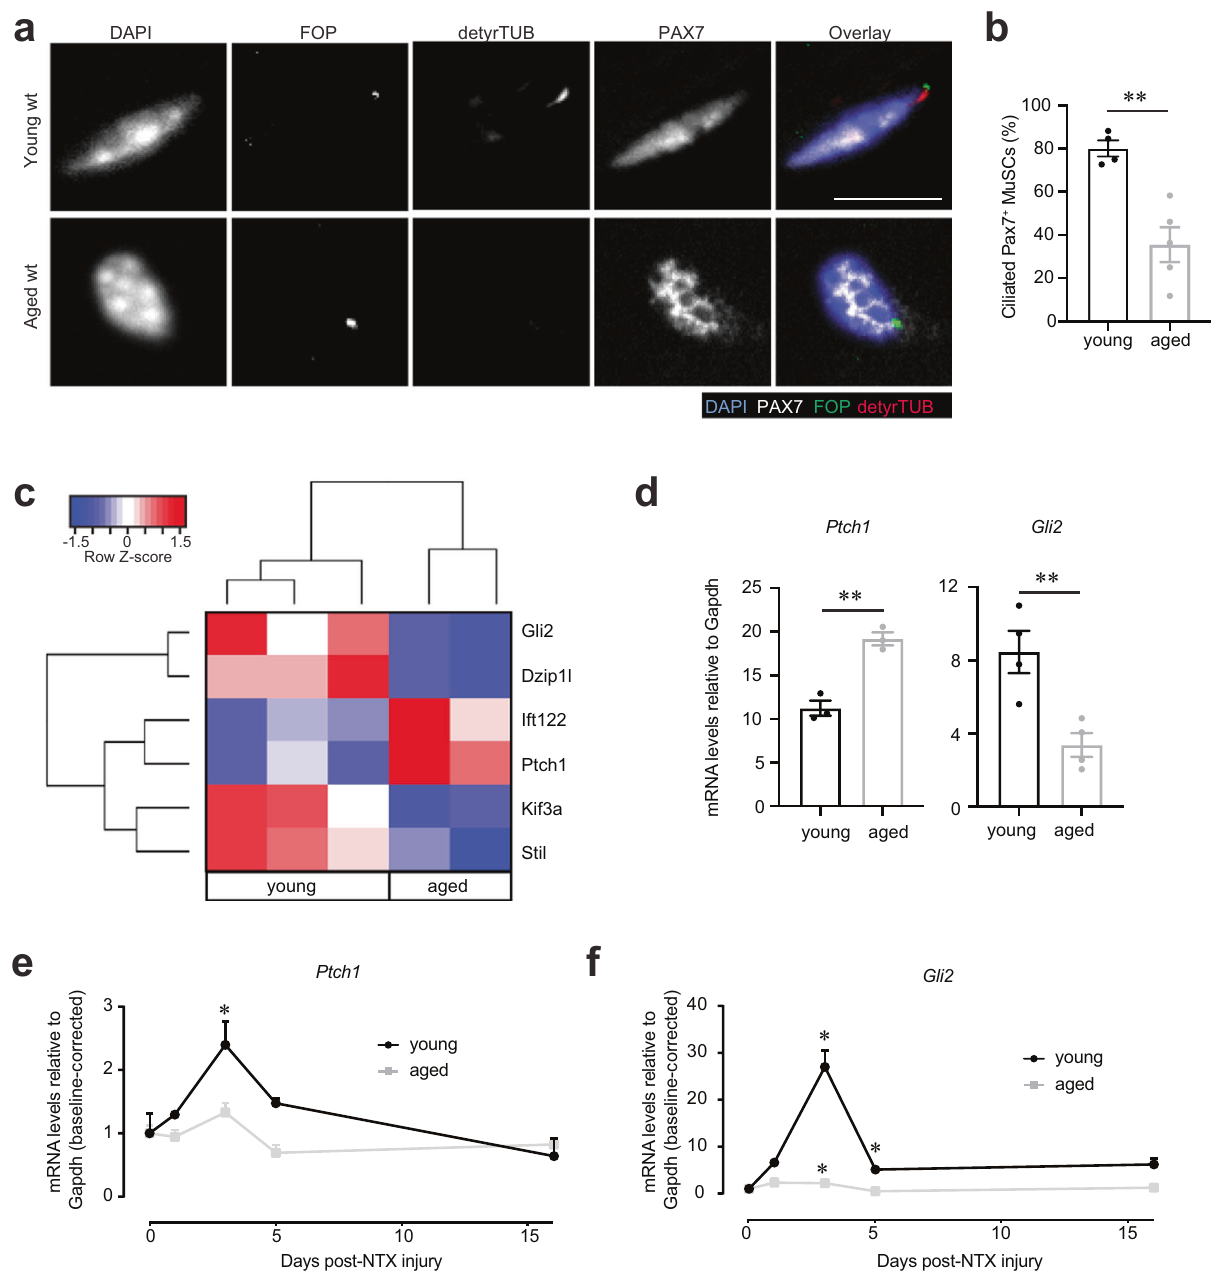
Fig. 4 Aged MuSCs present decreased ciliation and Hedgehog signaling. a Representative confocal images of uninjured/resting EDL myo fi bers of young (2 months) and aged (>24 months) C57BL/6 wild-type (wt) mice showing cilia immunostaining in Pax7 + MuSCs. Scale bars: 10 μ m. DAPI, blue; PAX7, white; FOP, green; detyrosinated tubulin, red. b Percent of ciliated Pax7 + MuSCs quanti fi ed from isolated myo fi bers ( n = 58 myo fi bers total per age group isolated from n = 4 young and n = 5 aged mice, average percent of ciliated MuSCs per mouse is shown). c Heat map of differentially expressed Hh pathway genes in young and aged MuSCs. d Expression of the negative regulator of Hh signaling, Ptch1 , is increased in aged MuSCs, while the target gene Gli2 is decreased in aged MuSCs compared to young as determined by qPCR analysis ( n = 4 mice per age group). e , f Expression of Ptch1 ( e ) and Gli2 transcription factor ( f ) after Tibialis anterior (TA) muscle injury (notexin) ( n = 3 – 7 mice per timepoint and age group, individual data points in Supplementary Fig. 4c, d). * P < 0.05, ** P < 0.01, *** P < 0.001 **** P < 0.0001. Mann – Whitney test ( b , d ). ANOVA test for group comparisons and signi fi cant difference for each timepoint relative to Day 0 by Fisher ’ s LSD test ( e, f ). Source data are provided as a Source Data fi le. Means + the Sonic-Hedgehog (Shh) ligand which activates signaling by ~30% of ciliated aged MuSCs suf fi ces to improve muscle regen- binding PTCH1 and derepressing SMO 39 . We found that each of eration in the aged, we treated isolated MuSCs from aged mice with SAG1.3. This resulted in a signi fi cant increase in proliferation the SMO agonists we tested signi fi cantly enhanced aged MuSC (Fig. 5a). To con fi rm this fi nding, we treated aged MuSCs with proliferation (Fig. 5b). Moreover, we validated that SAG1.3 treat- other known agonists of SMO, including small molecules (pur- ment of aged MuSCs increased expression of the downstream Hh morphamine and GSA-10) 36 , the glucocorticoid fl uticasone 38 , and target Gli2 (Fig. 5c).